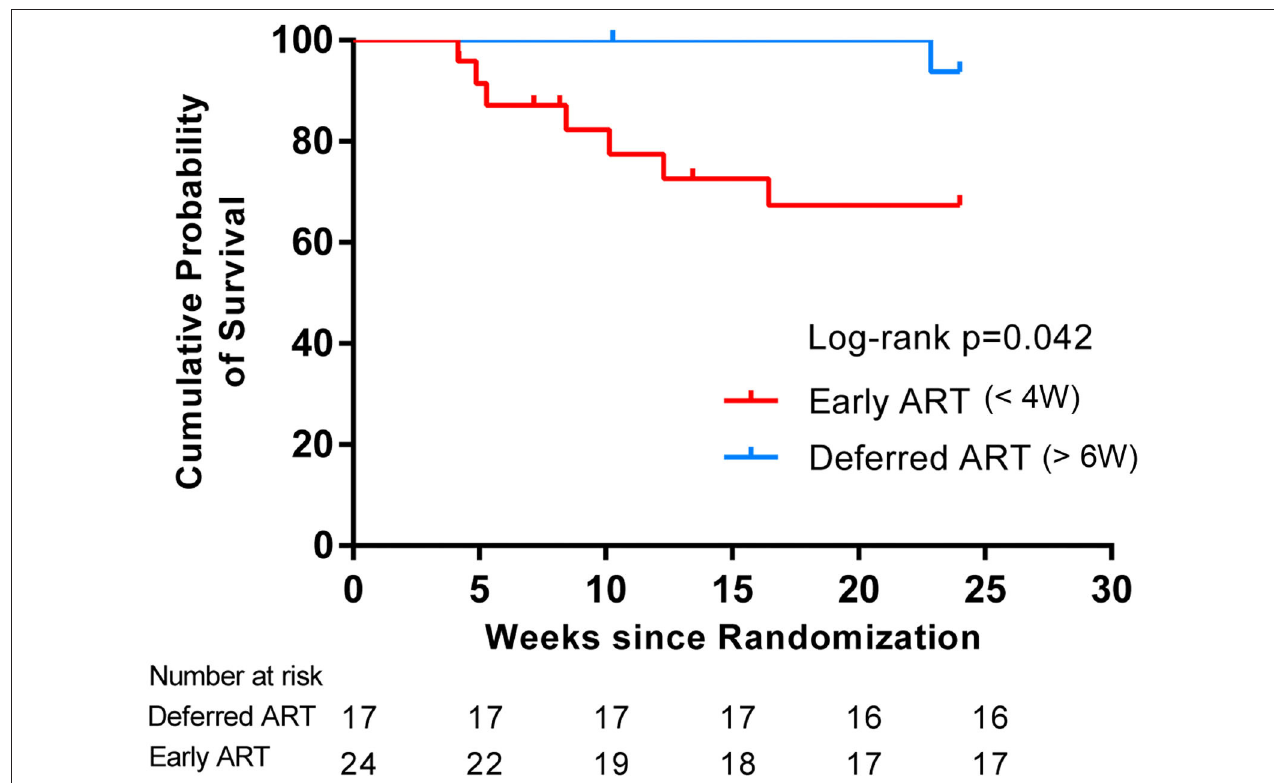
FIGURE 3 | Kaplan-Meier curves for survival rates and timing of ART initiation. The subgroup analysis was assessed to determine whether stratification of ART initiation timing had an effect on survival in each treatment group. Initiating ART within 4 weeks after the diagnosis of CM resulted in a higher mortality compared with deferring ART initiation until 6 weeks, suggesting a differential response to the timing of ART